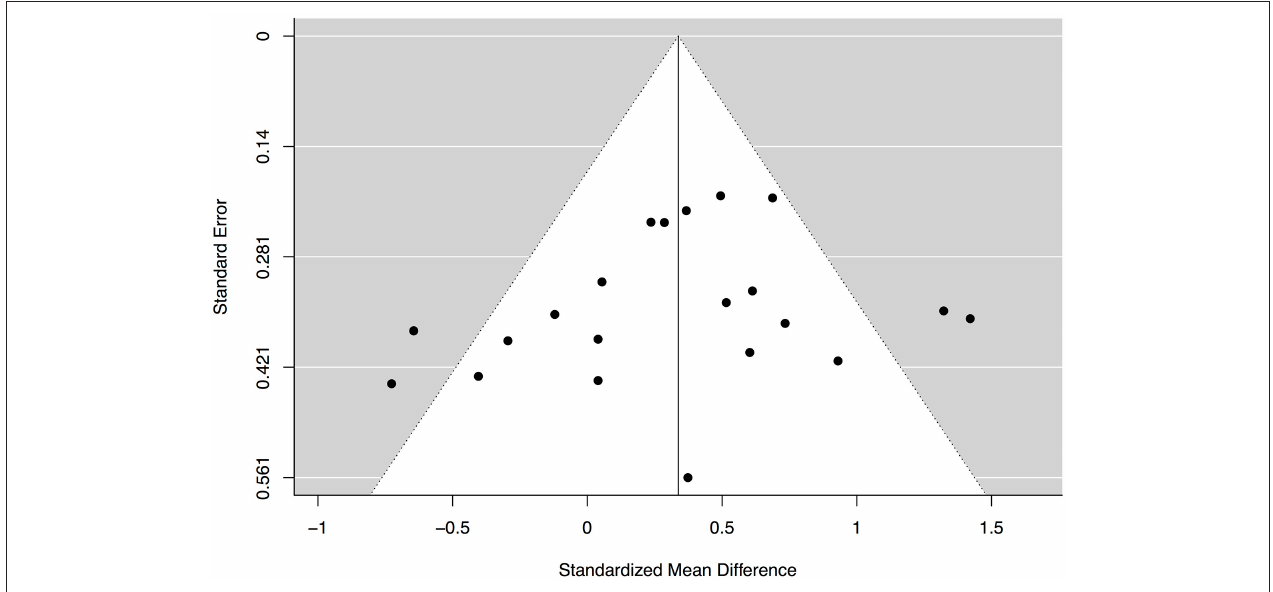
FIGURE 4 | Funnel plot assessing the risk of publication